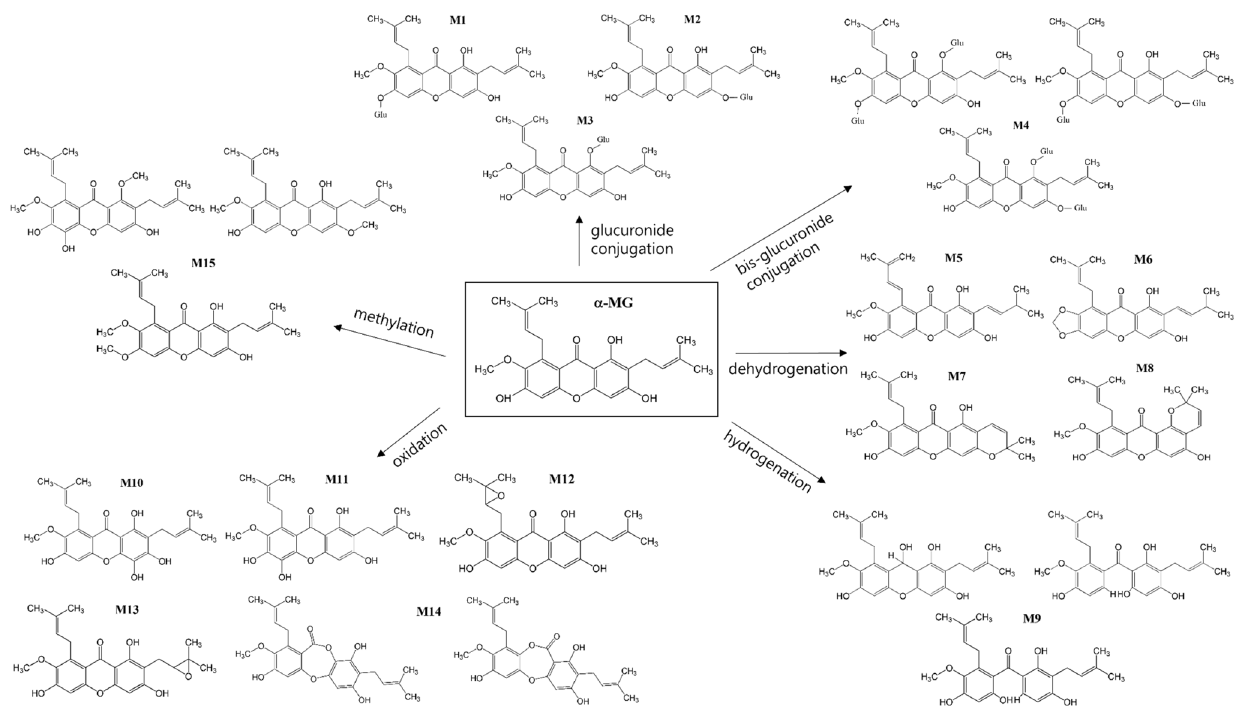
Fig 7. Proposed structures and metabolic pathways of metabolites in mice ’ s plasma, urine, feces, liver and small intestine after intravenous and oral administration of α -MG and S9 fractions of the liver and small intestine after 30 min incubation.